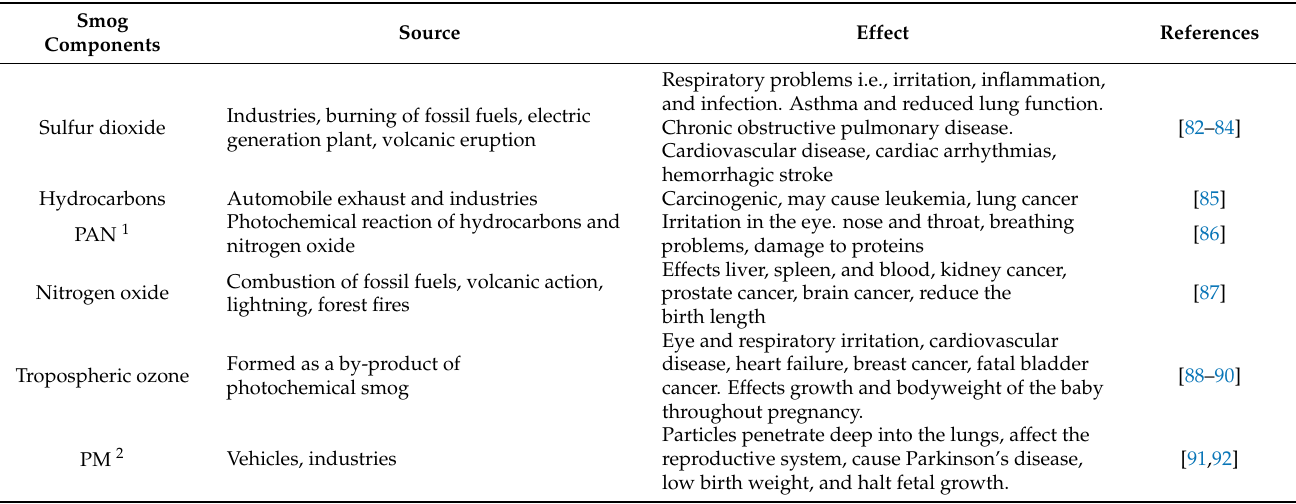
Figure 4. Effect of smog particles on different organs (nervous system, eyes, throat, lungs, heart, liver, spleen, and reproductive system) of the human body and the problems associated with it. Table 8. Sources and diseases associated with sulfur dioxide, hydrocarbons, peroxyacetyl nitrate, nitrogen oxide, tropo- spheric ozone, and particulate matter i.e., different components of